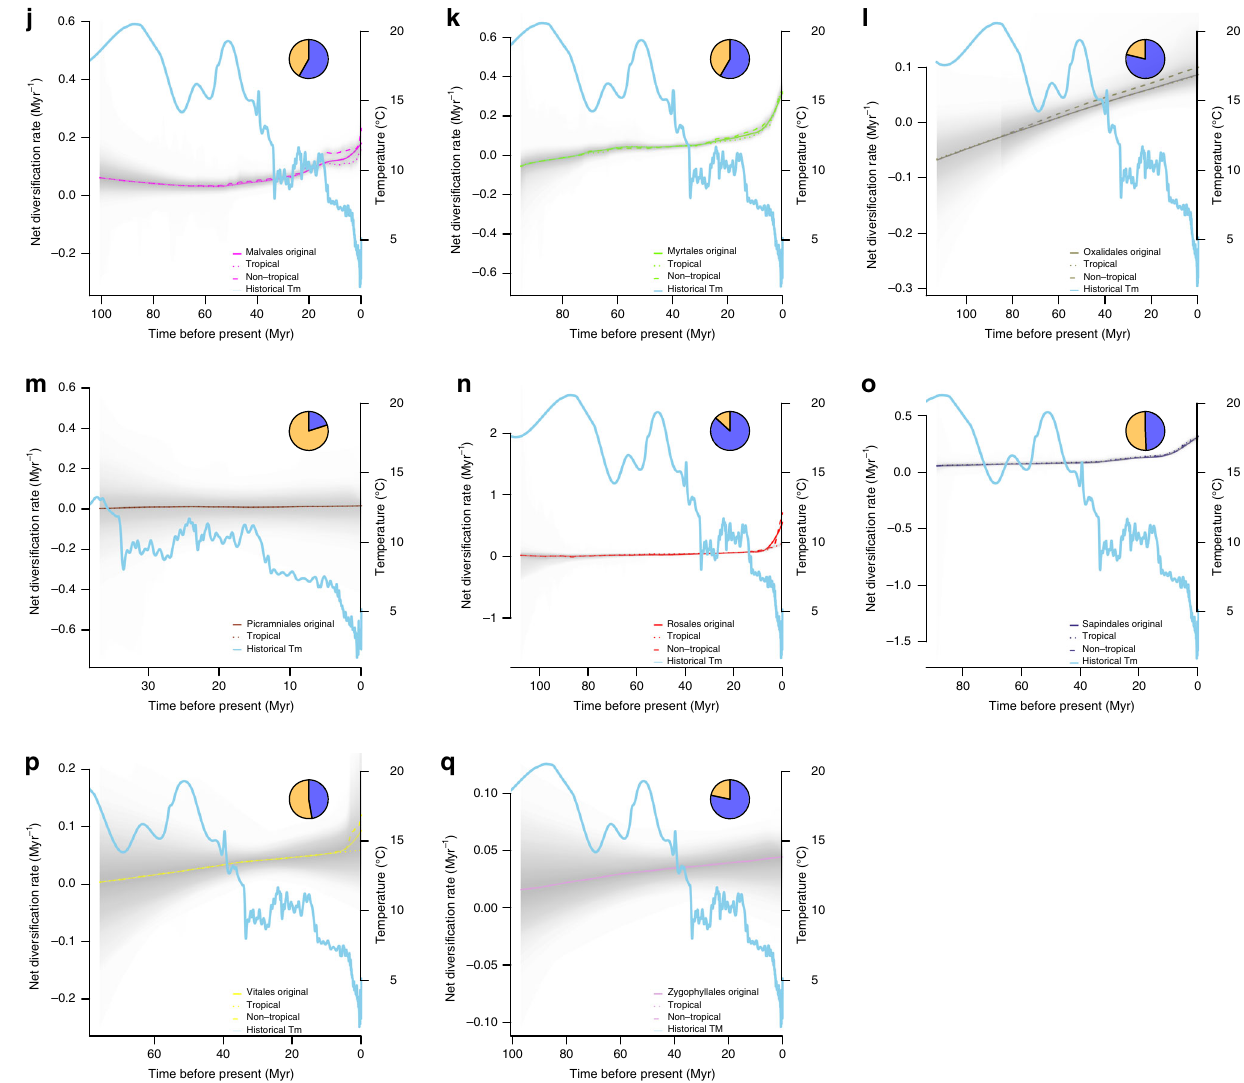
Fig. 3 Trends in net rosid diversi fi cation rate-through-time plots of tropical and non-tropical lineages against global temperature. Net diversi fi cation rate curves were generated using BAMM for each of the 17 rosid orders (clades) ( a – q ); each curve is a median line colored by order; the solid line is the original net diversi fi cation rate curve, the dotted line represents the rate of tropical lineages, and the dashed line represents the rate of non-tropical lineages (no curves displayed for any lineage with sample number < 3). The gray segment is the 95% con fi dence interval; the sky blue line is the trend of global temperature change since the Late Cretaceous (~113 Myr), plotted as a 5-point mean derived from Cramer et al. 59 ; the pie-chart represents the percentage of tropical (orange) and non-tropical (blue) species within each order summarized from the Köppen – Geiger climatic classi fi cation 43 . Each timescale ( x axis) is rescaled to the clade